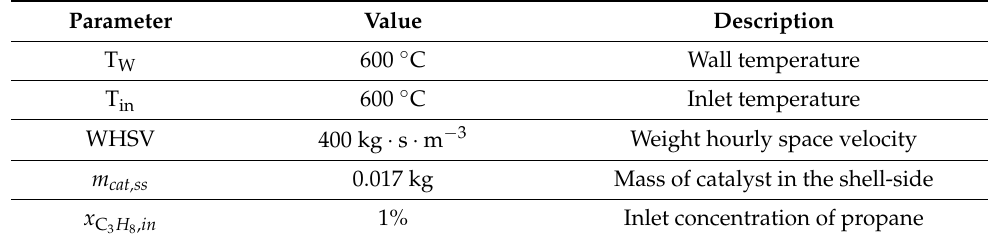
Table 1. Reaction conditions of the steady-state simulations.